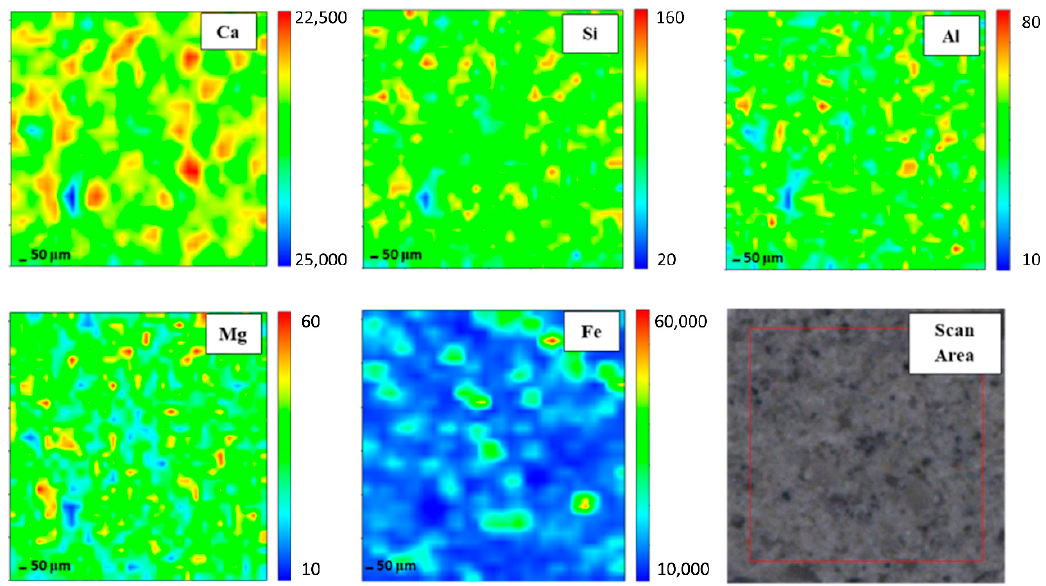
Figure 3. Micro-XRF elemental mapping of Ca, Si, Al, Mg and Fe in a ~961 × 50 µ m overview of dolomite/fly ash geopolymer composites after exposure at 400 ° C.